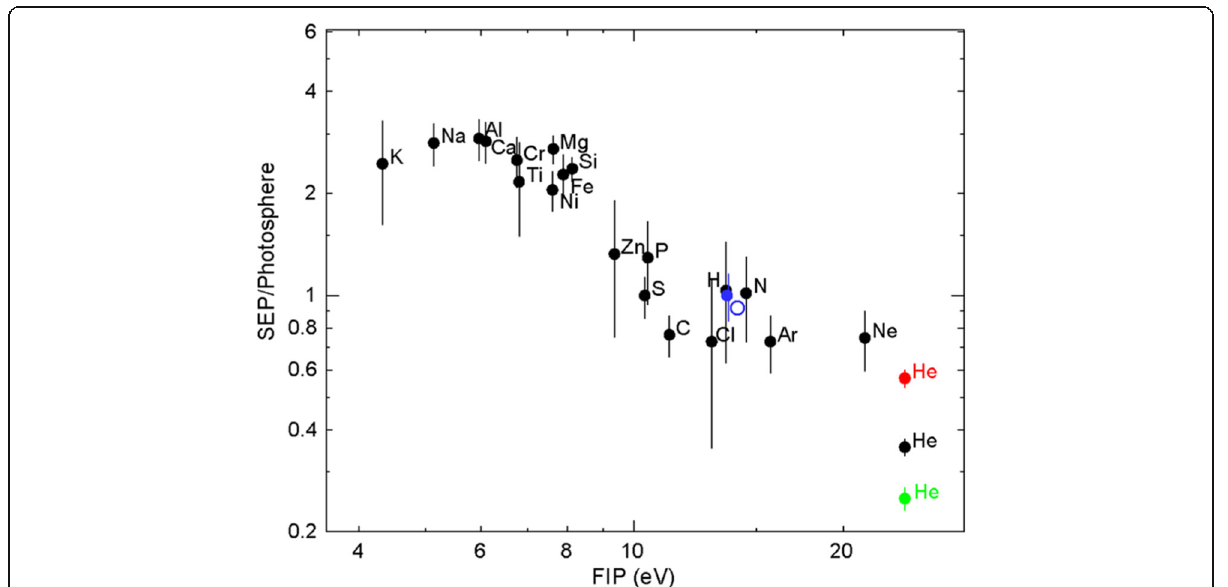
Fig. 25 SEP abundances (from Reames 2014) divided by photospheric abundances (from Reames 2014) divided by photospheric abundances (from Caffau et al. 2011, Lodders et al. 2009), normalized at O (blue). Abundances of He in three SEP events are also shown (taken from Reames 2018)